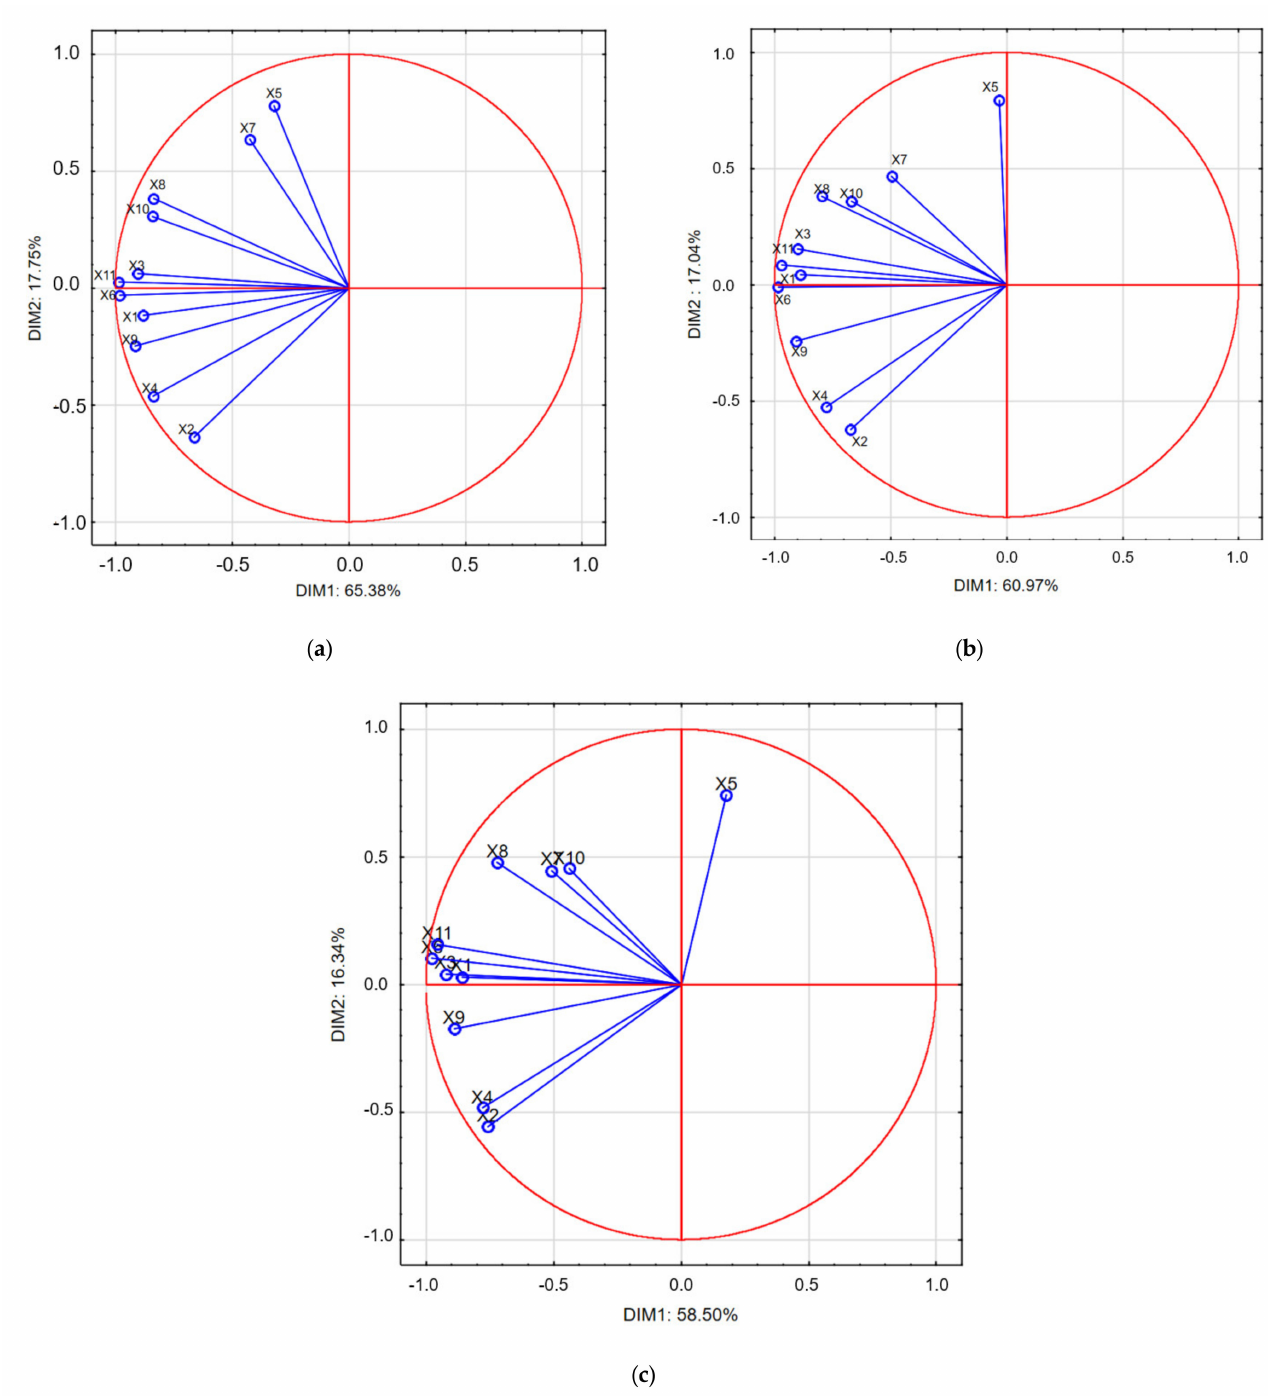
Figure 4. Location of vector loadings in relation to the two principal components (( a )—2008, ( b )—2013, ( c